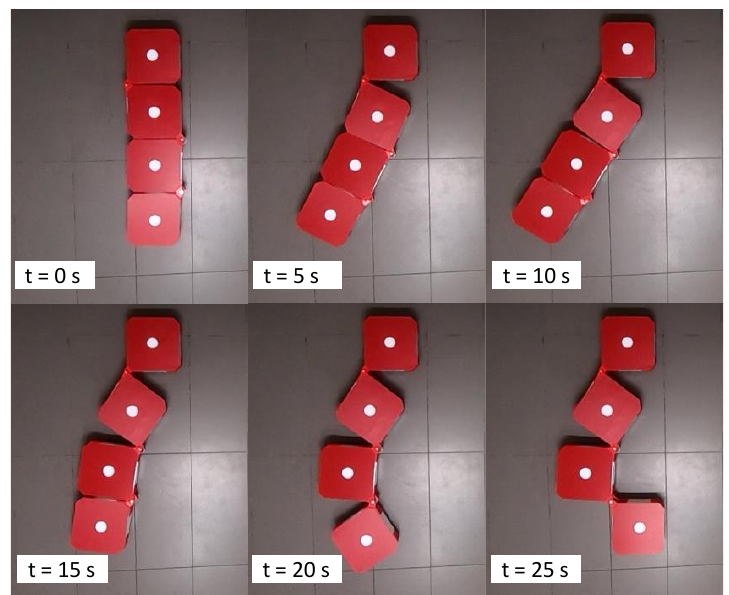
Figure 6. Snapshots taken during a reconfiguration of the robot.